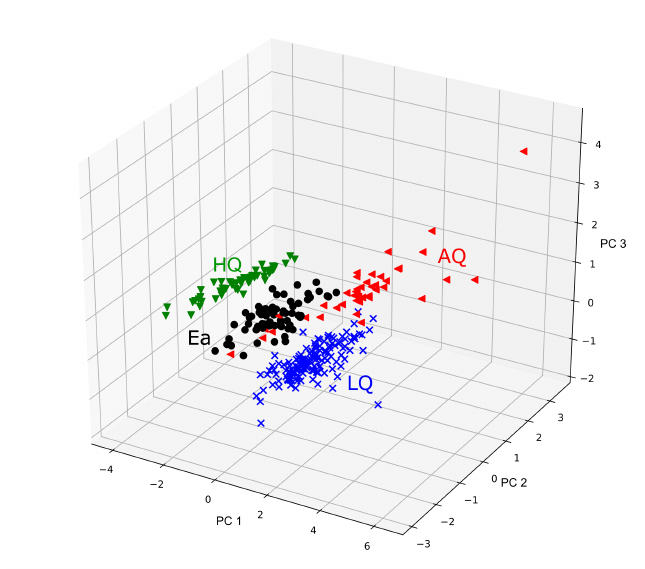
Figure 3. Example of transformed feature characteristics extracted from the sensors by Principal Components Analysis (PCA). Features from all sensors are considered, and the best five features selected by the forward selection method are used as input to PCA. The four studied wine categories are marked by colors: LQ–low quality, AQ—average quality, HQ—high quality, and Ea—diluted